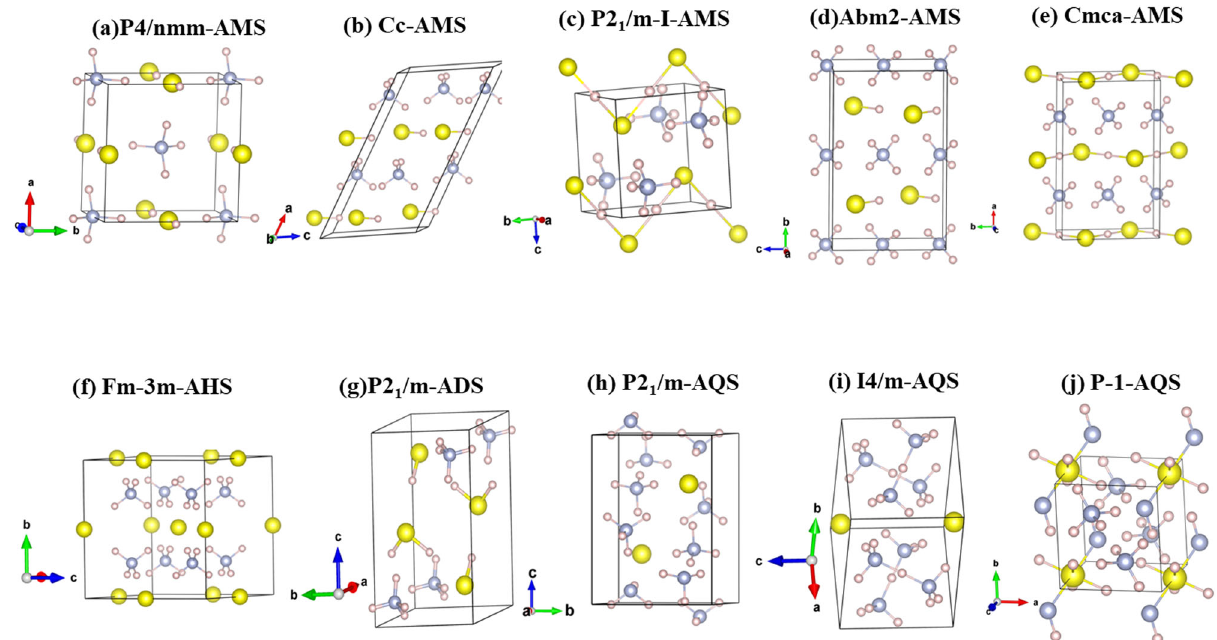
Fig. 2 Crystal structures of stable compounds in the H 2 S-NH 3 system. a – j Crystal structures of H 2 S-NH 3 structures as labeled. Yellow (blue, pink) spheres denote sulfur (nitrogen, hydrogen) atoms, and covalent bonds are indicated by thin lines. Unit cells and crystallographic axes are as shown.